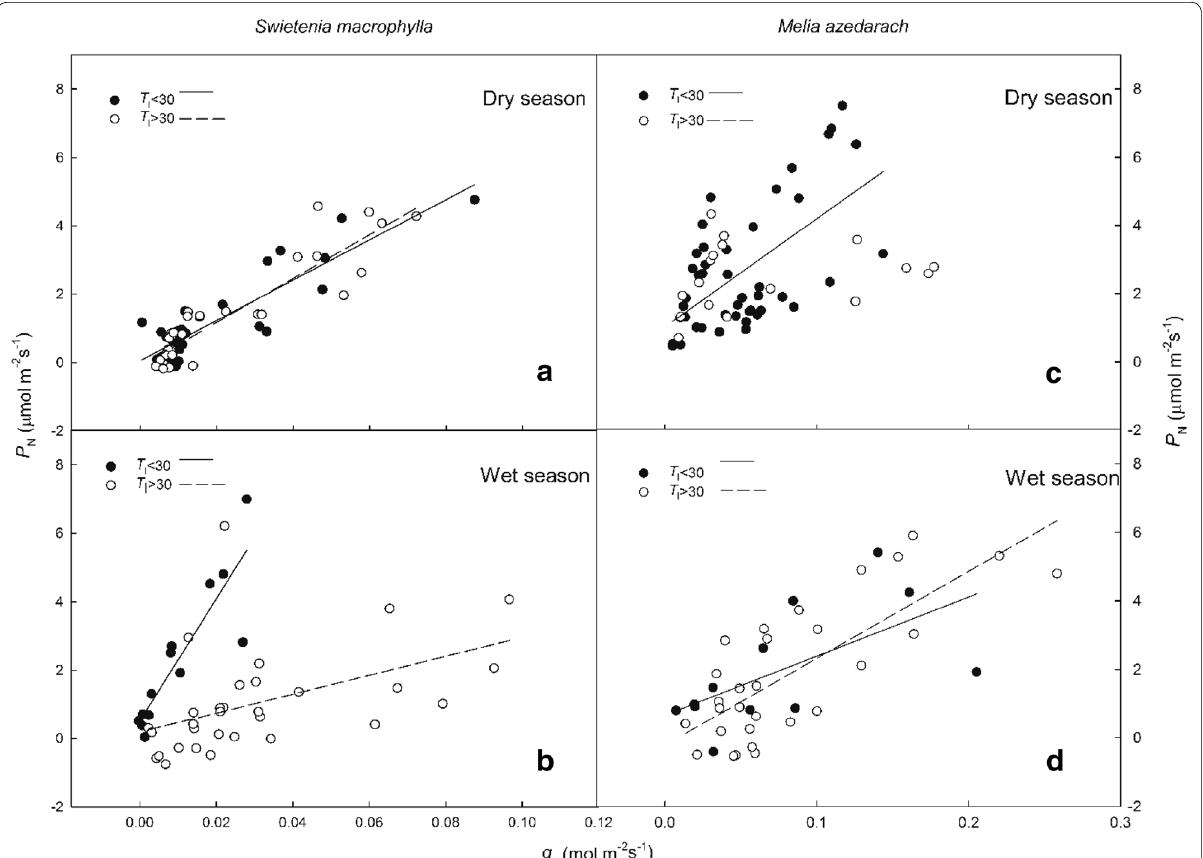
Fig. 5 Relationship between Swietenia macrophylla and Melia azedarach stomatal conductance ( g s ) and net photosynthetic rate ( P N ) in dry ( a , c ) and wet ( b , d ) seasons at different leaf temperatures ( T l